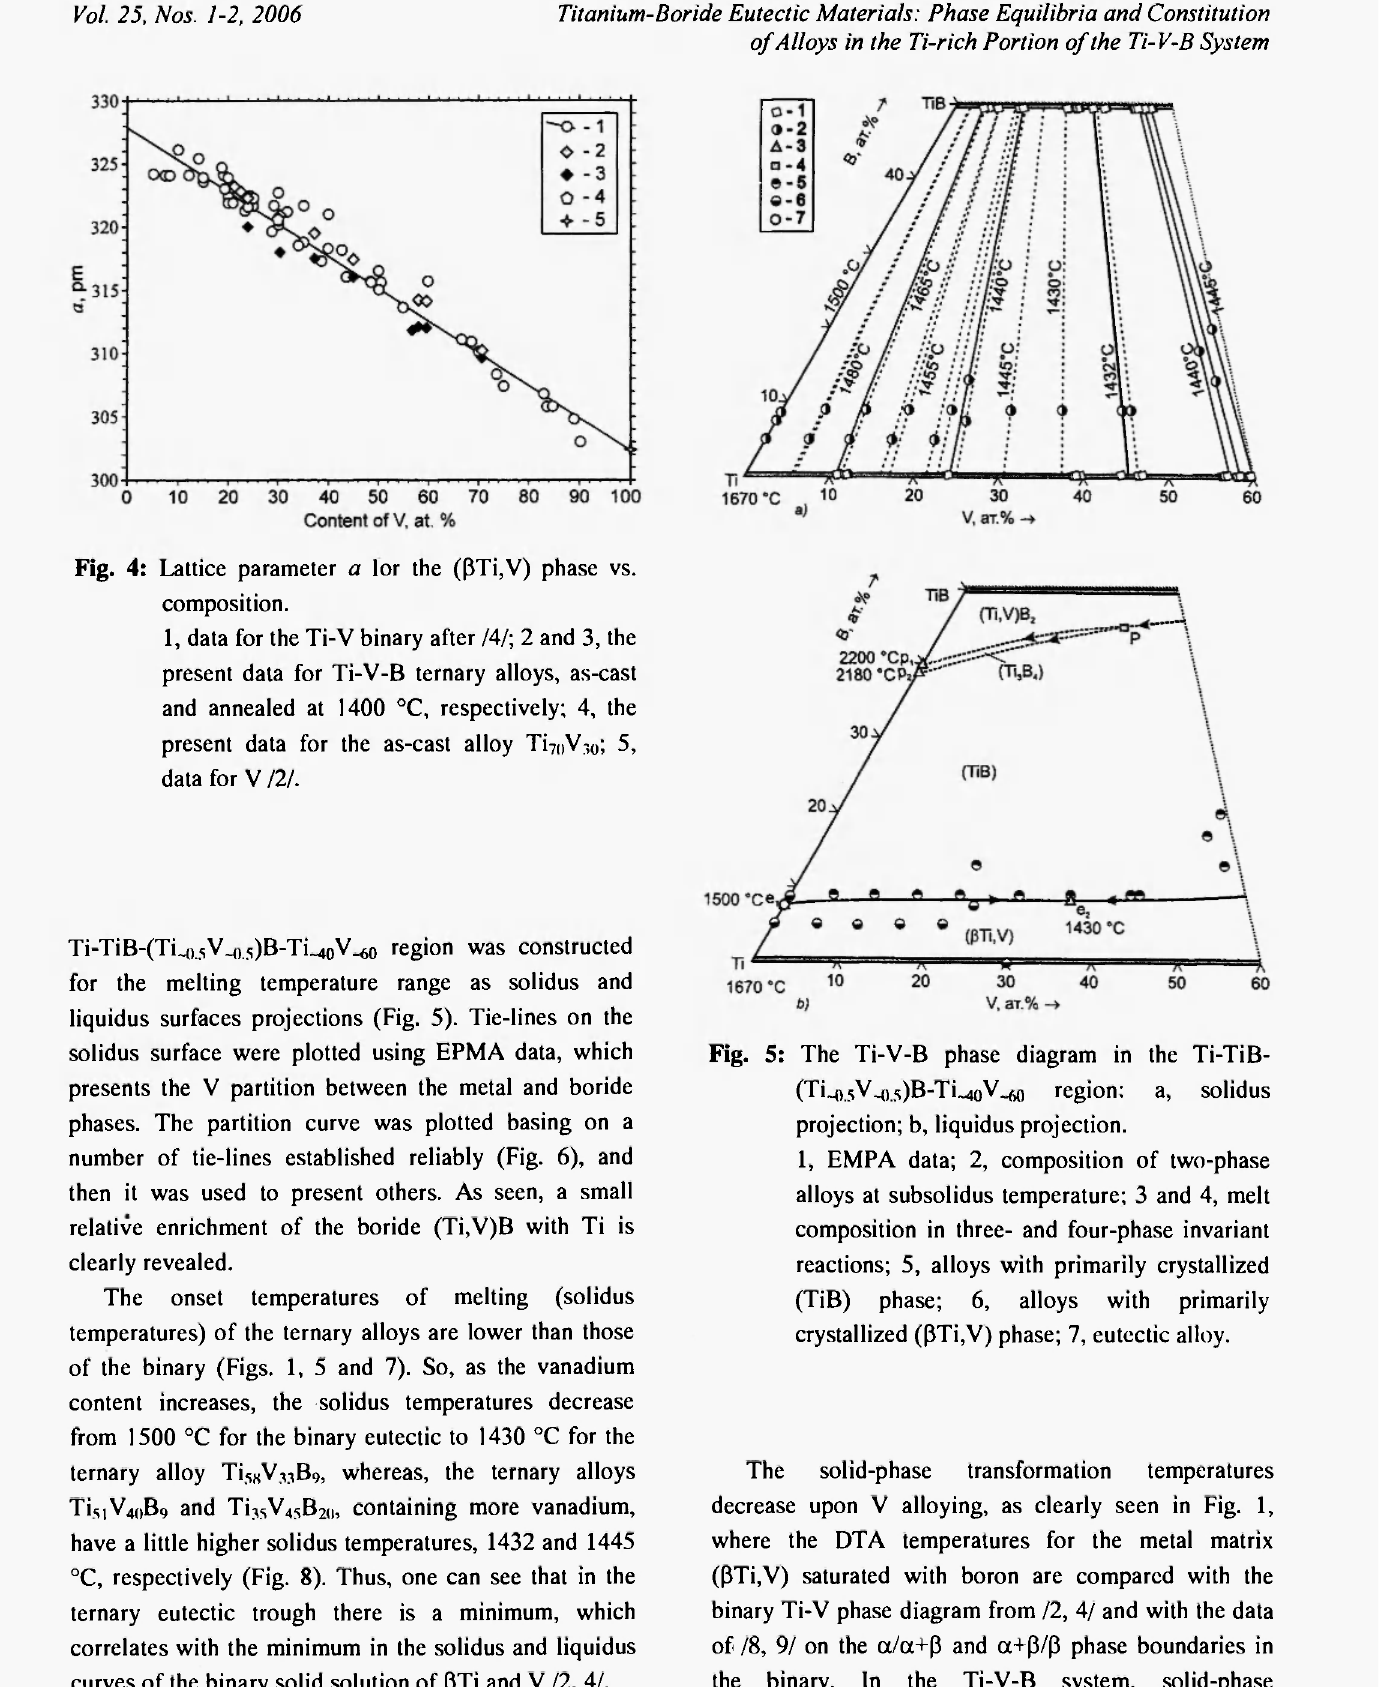
Fig. 5: The Ti-V-B phase diagram in the Ti-TiB- (Ti^). 5 V_ 0 . s )B-Ti-4 0 V-60 region: a, solidus projection; b, liquidus projection. 1, EMPA data; 2, composition of two-phase alloys at subsolidus temperature; 3 and 4, melt composition in three- and four-phase